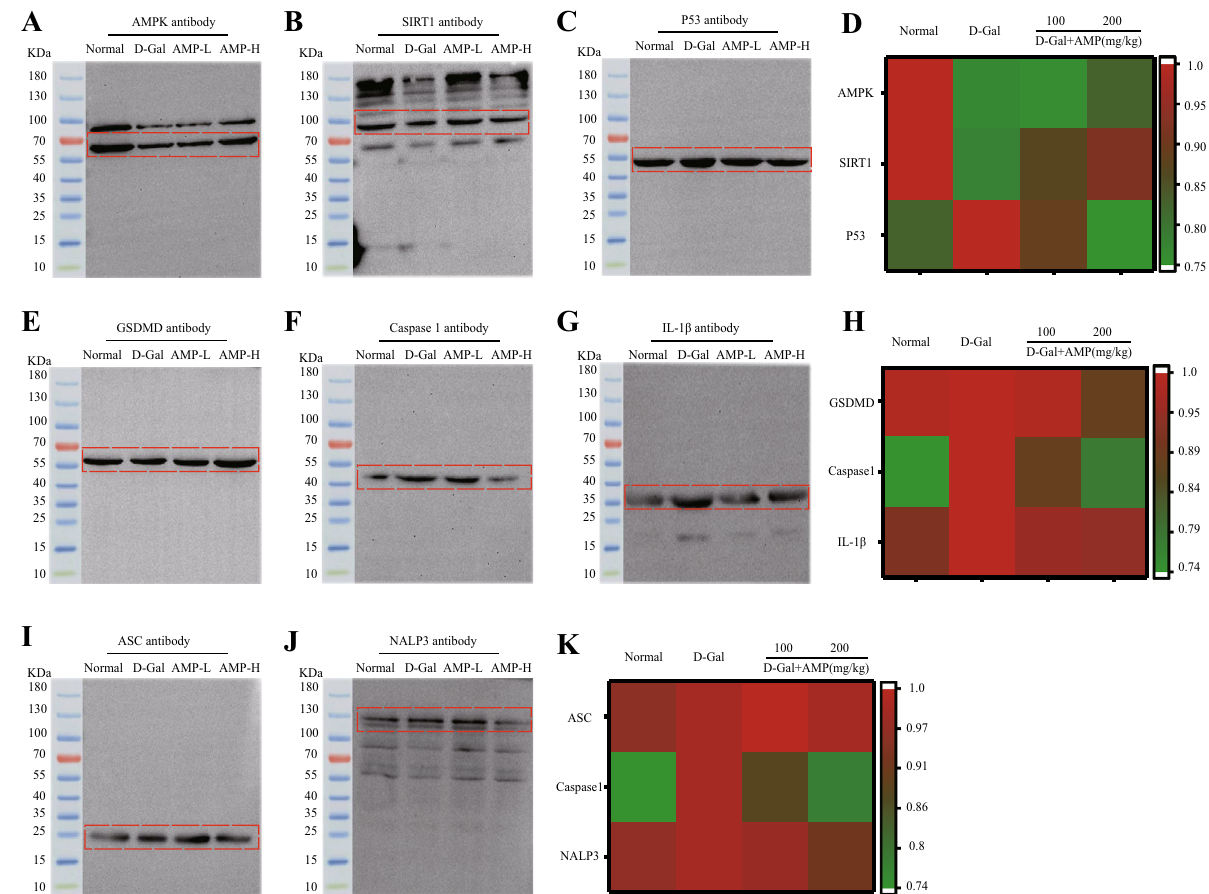
Figure 4. AMP improves D-Gal-induced oxidative stress. ( A – D ) AMPK, SIRT1, and P53 proteins expression, and heat map analysis of AMPK signaling pathway expression levels. ( E – K ) Inflammasome proteins expression of GSDMD, Caspase 1, IL-1β, ASC, and NALP3, and heat map analysis of inflammasome protein expression levels. Data are expressed as the mean ± standard deviation (S.D), n = 10. *p < 0.05 or **p < 0.01 vs. normal